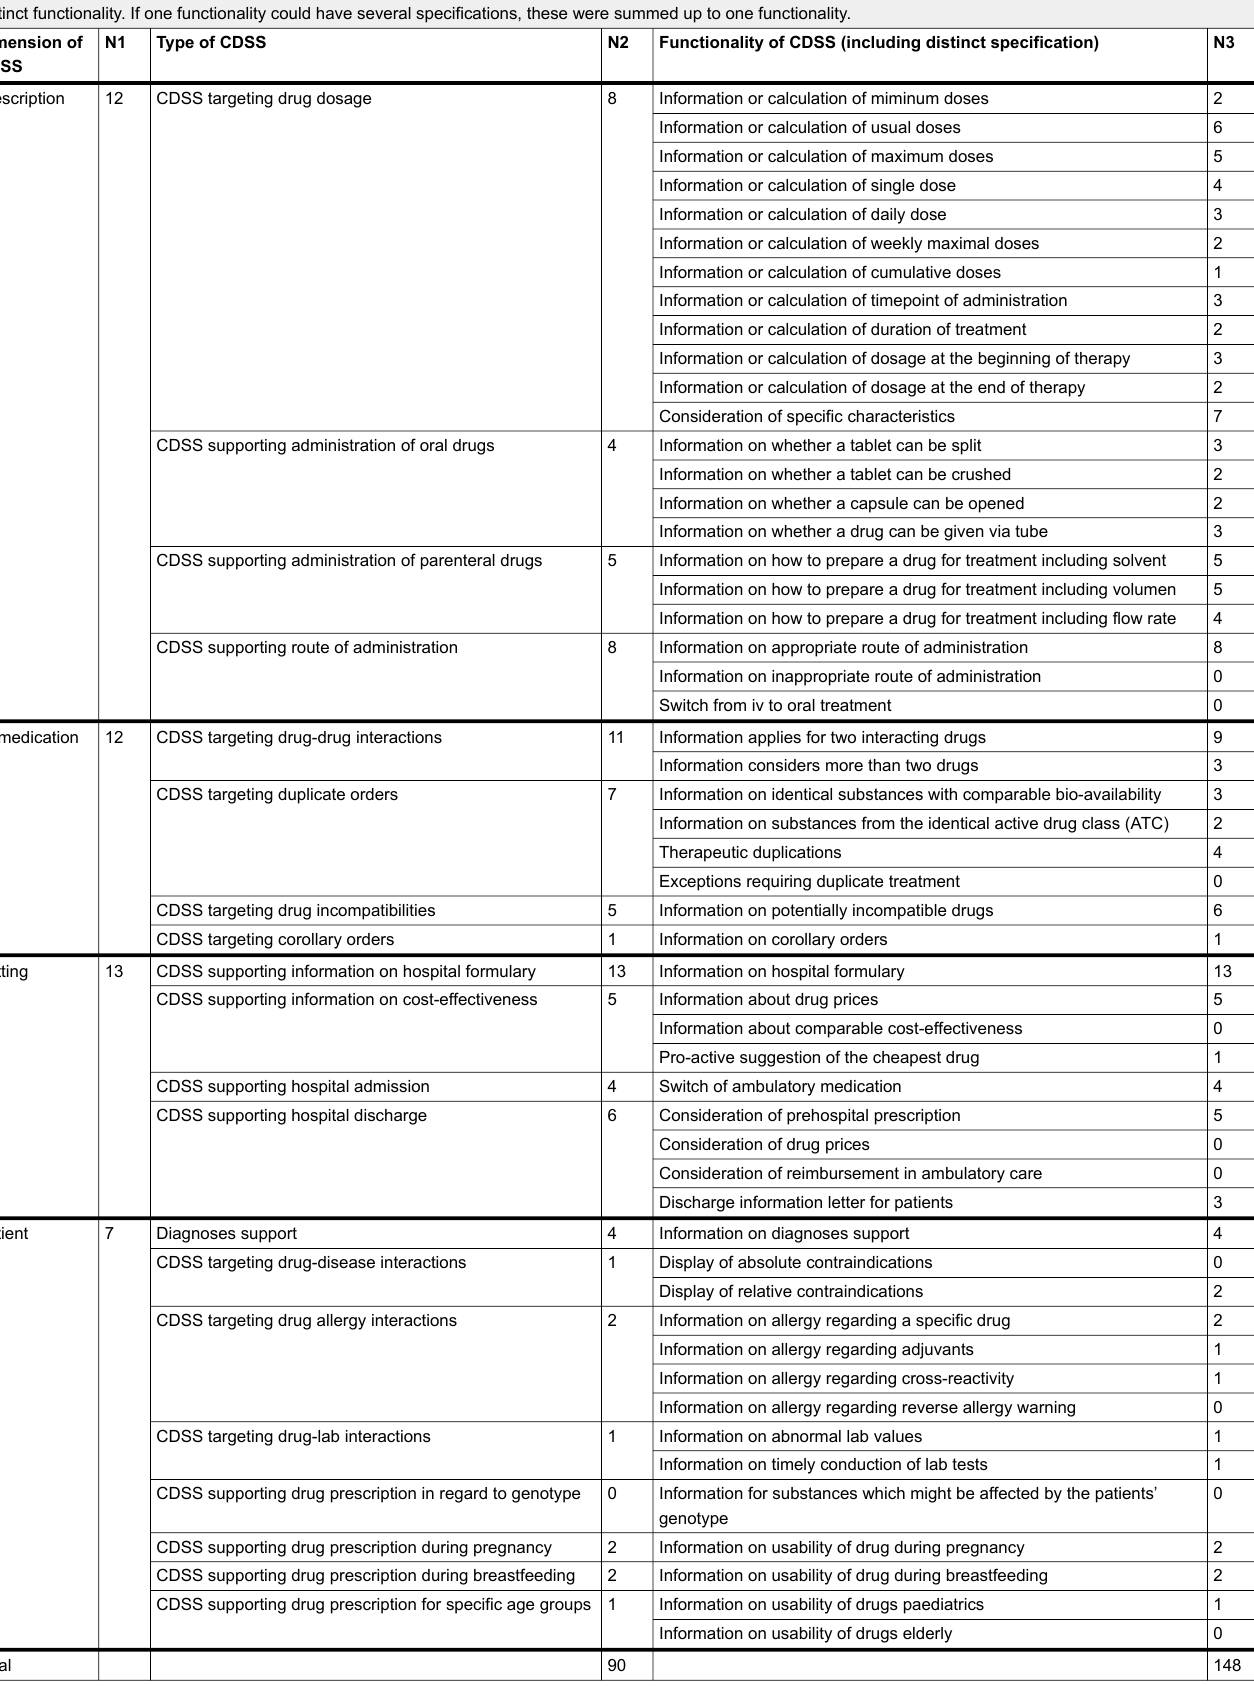
Table 3: Rate of implementation stratified for different types of CDSS. In total, 92 implementations of different types of CDSS were reported (= 100%) in the 14 establishments with CDSS implementation counted. N = number of institutions. N1 = Number of establishments with at least one CDSS functionality being part of the respective dimension or a respective type of CDSS. N2 = Number of implementations of a distinct type of CDSS; N3 = Number of the respective implementations of a distinct functionality. If one functionality could have several specifications, these were summed up to one functionality. Dimension of